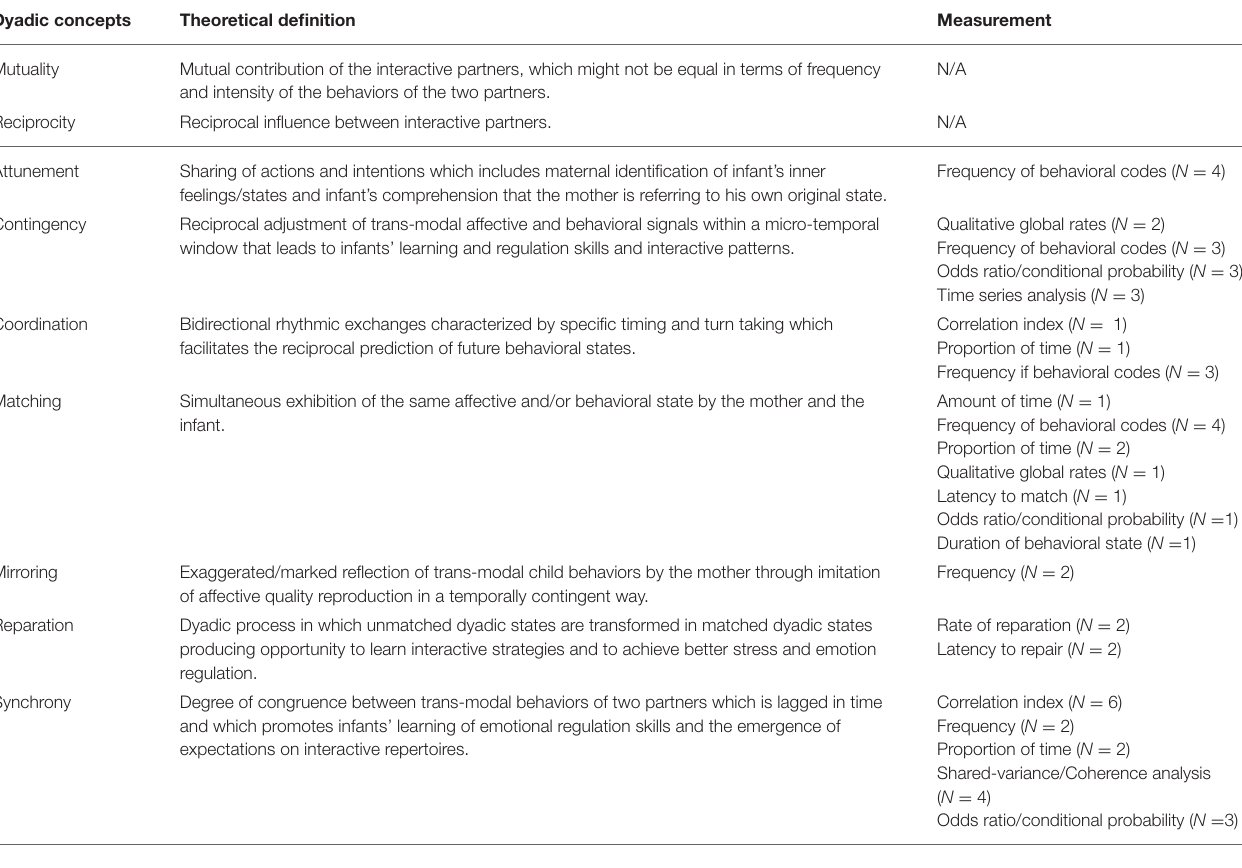
TABLE 3 | Theoretical definitions and measurement of dyadic concepts and processes.